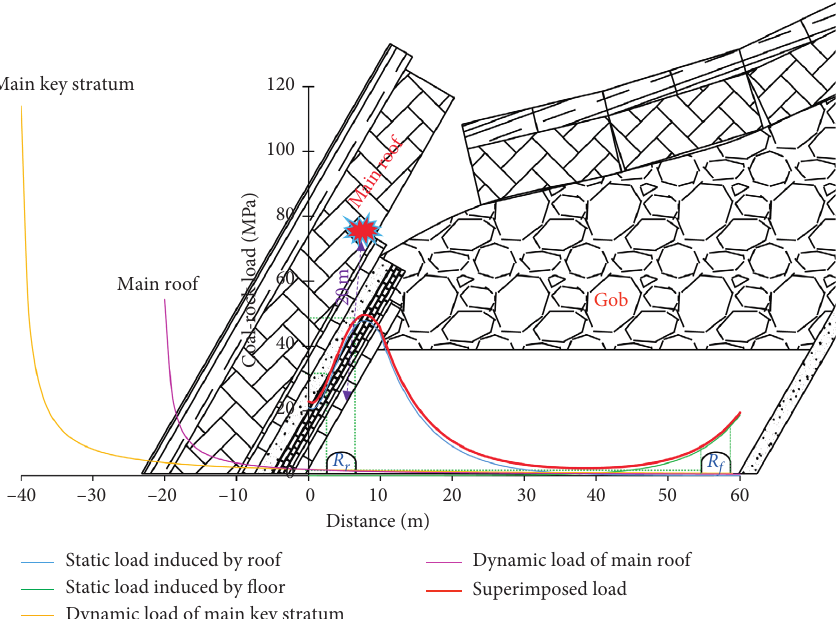
Figure 2: Distribution of dynamic load induced by roof breakage and static stress of the working